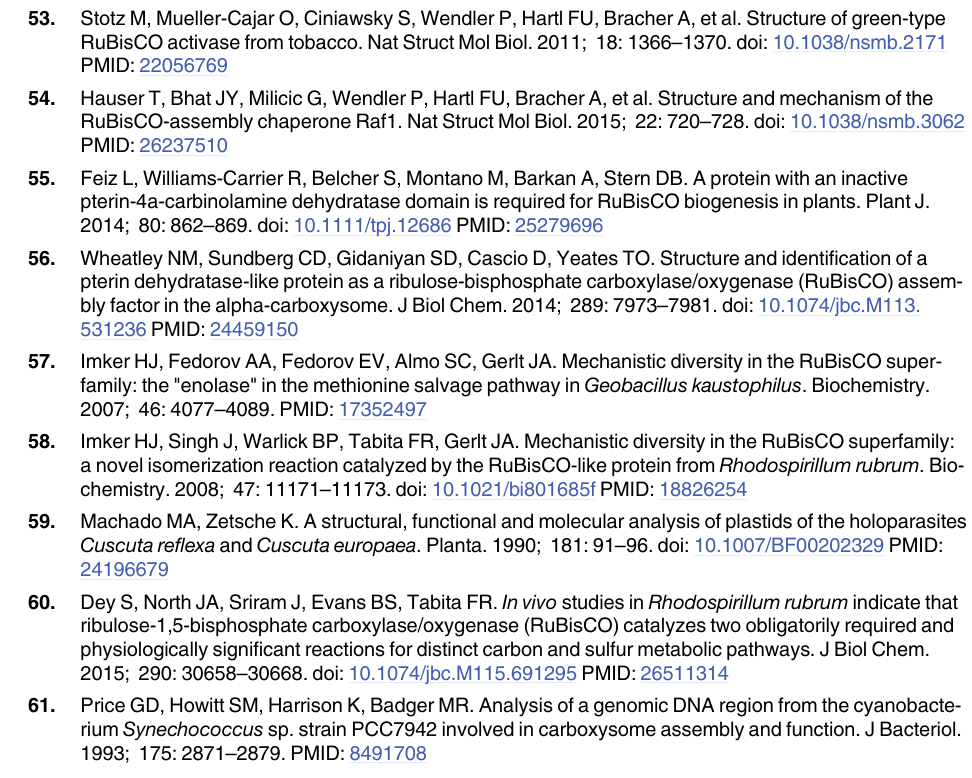
PLOS ONE | DOI:10.1371/journal.pone.0158790 July 8,